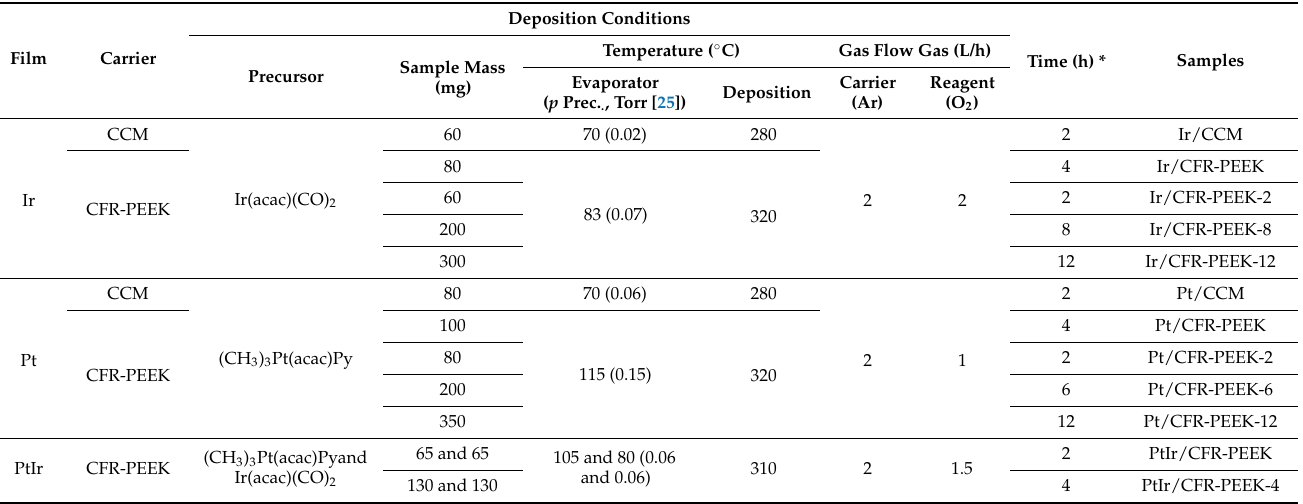
Table 1. Deposition conditions of the noble metal films and the sample designations. The sam- ples Ir/CCM, Ir/CFR-PEEK, Pt/CCM, Pt/CFR-PEEK and PtIr/CFR-PEEK (without/with surface modification by Ag and Au) were selected for biological